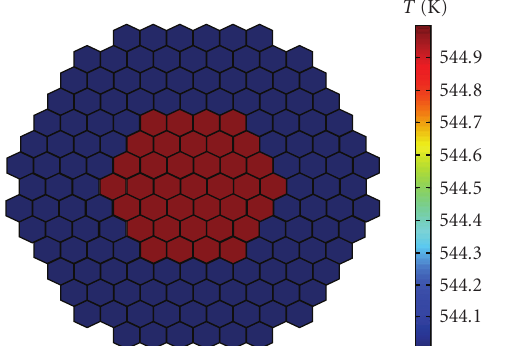
Figure 16: Predicted coolant temperature at the core outlet at initial state (0 second).